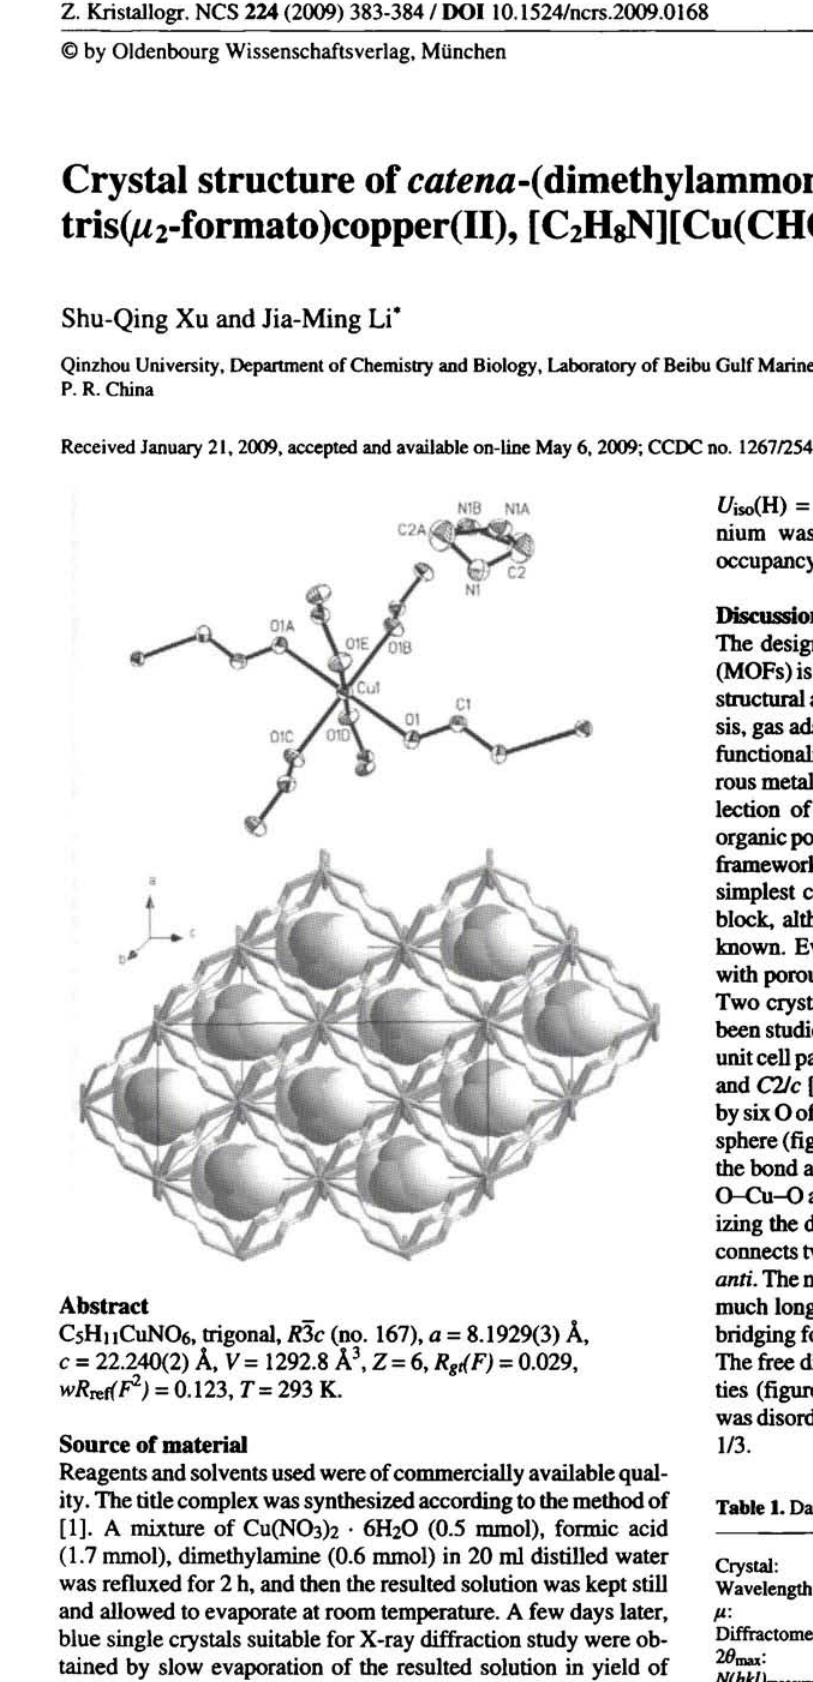
Table 1. Data collection and